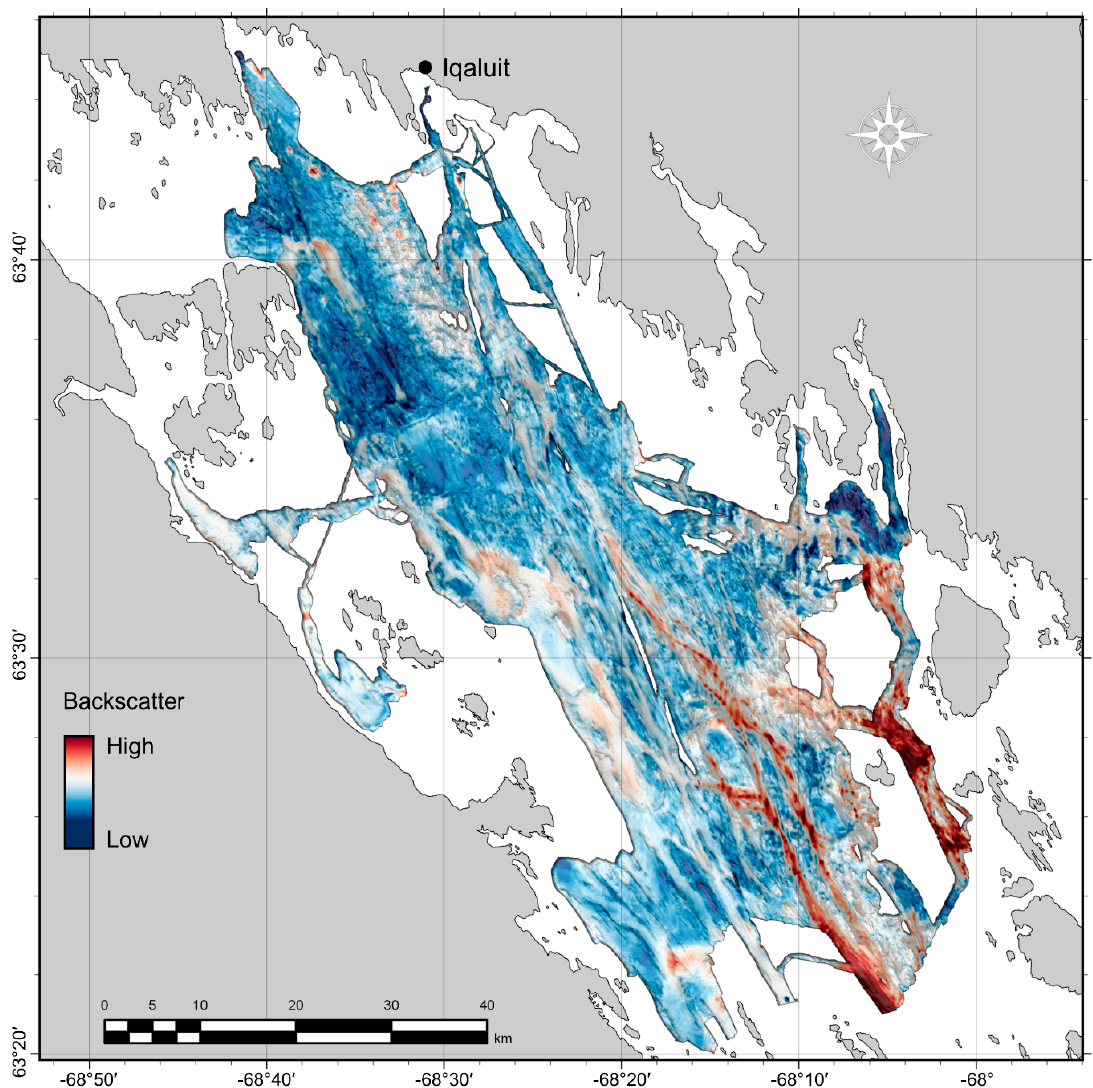
Figure 5. Inner Frobisher Bay relative MBES backscatter.